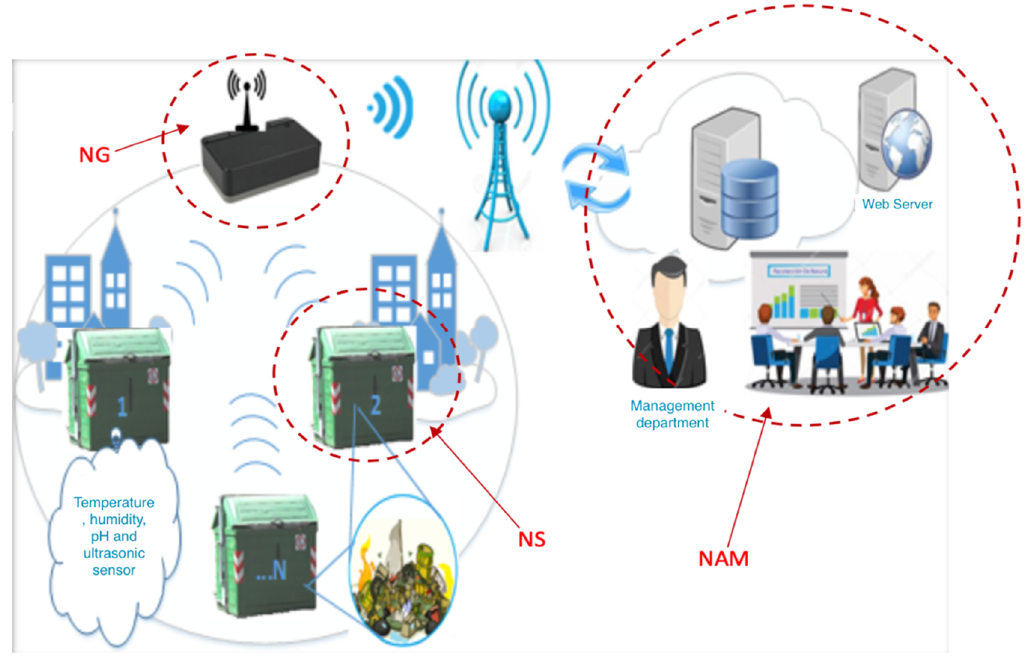
Figure 1. General system structure.